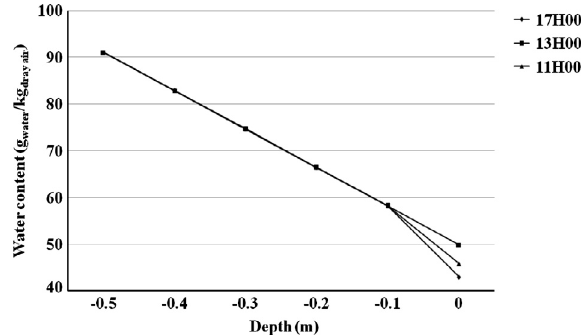
Figure 13. Water content evolution in terms of depth (January 15).